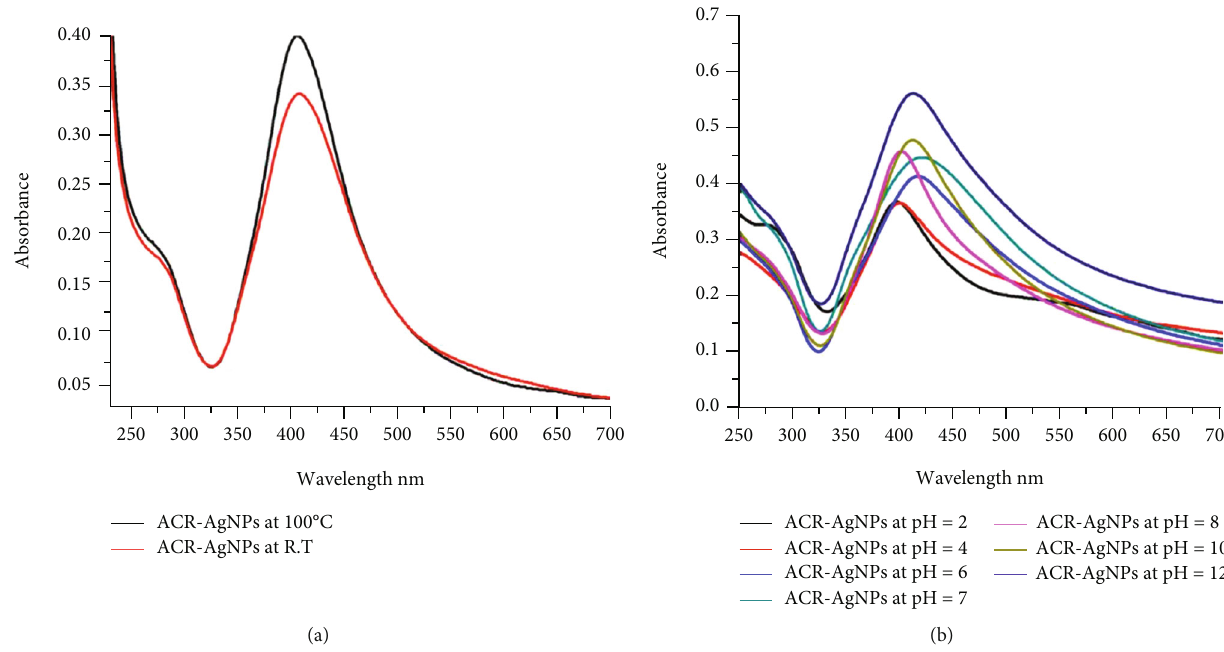
Figure 5: Stability of ACR-AgNPs. (a) E ff ect of temperature treatment. (b) E ff ect of pH on the stability of